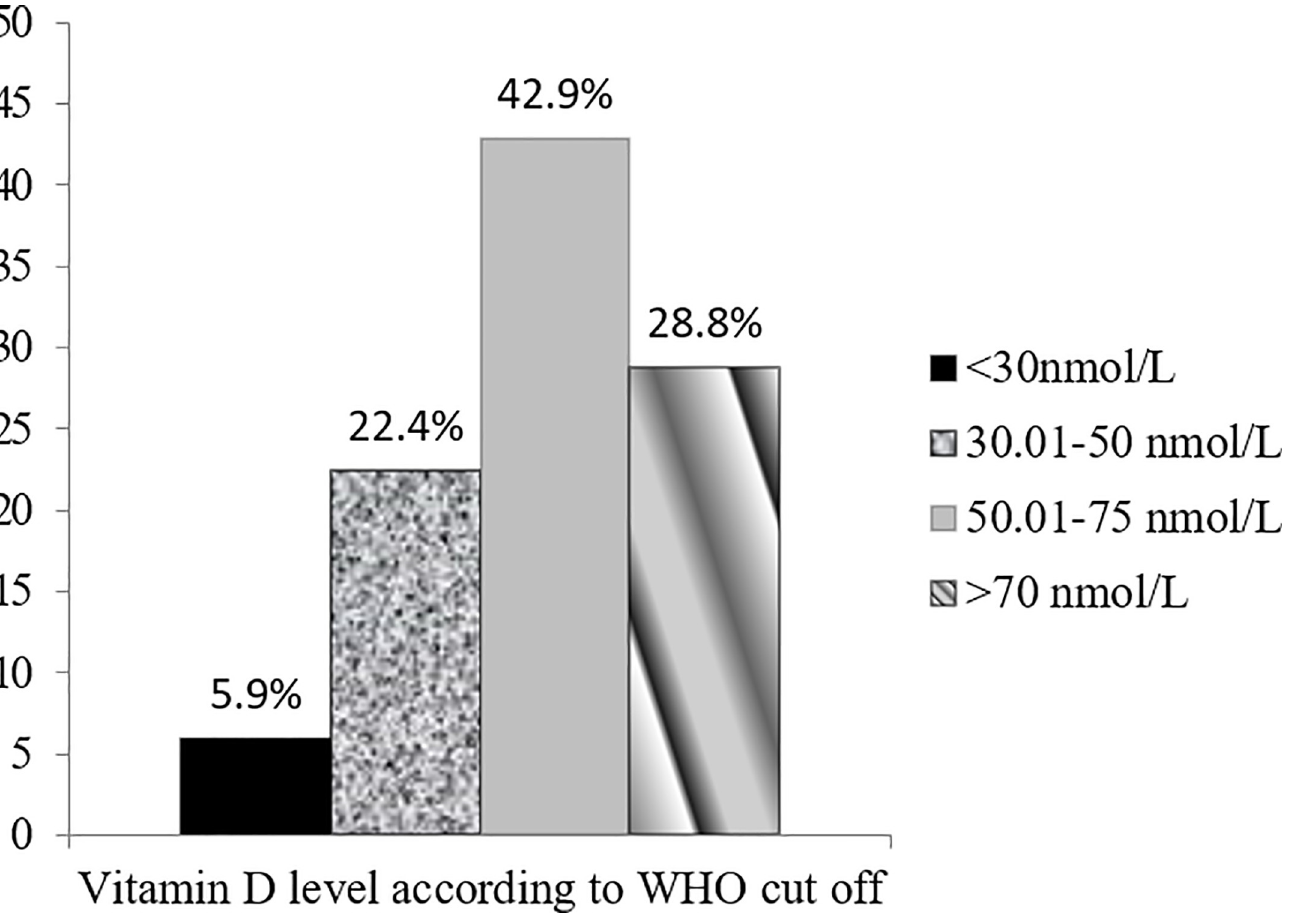
Fig 1. Distribution of vitamin D level in the